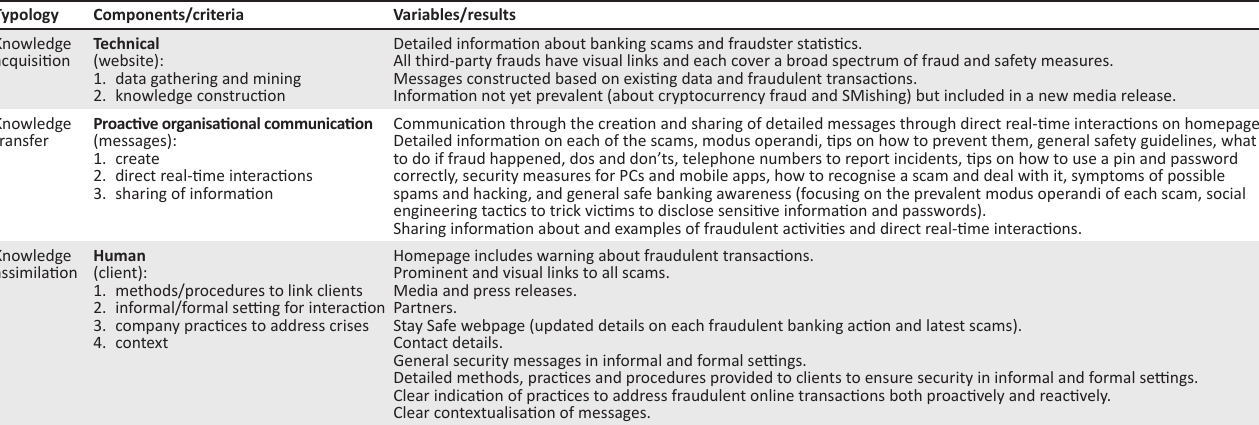
TABLE 2: Data analysis based on knowledge management typologies.